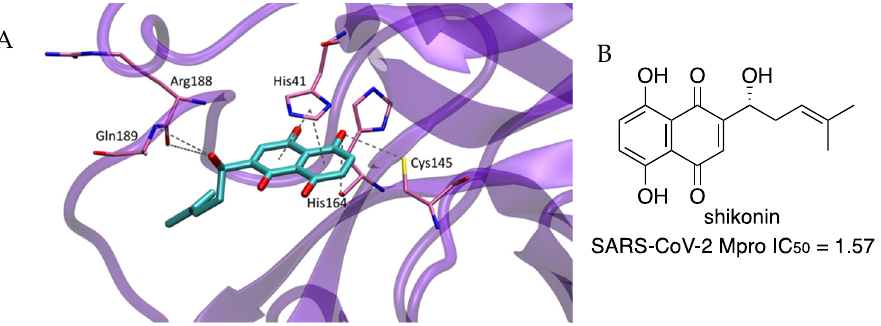
Figure 18. ( A ) Detail of crystal structure of the complex formed between shikonin and SARS ‐ CoV ‐ 2 Mpro. ( B ) Chemical structure of shikonin.